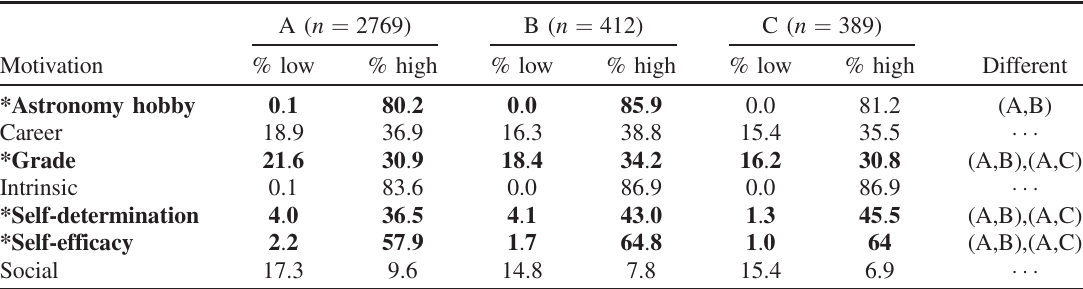
TABLE V. Comparison of percentages of learners in low and high tiers of each motivational category for those who A — dropped out before the first peer graded assignment, B — dropped out after the first peer graded assignment, and C — finished the course. The Kruskal-Wallis test was performed on each line and statistically significantly different groups per Dunn ’ s post hoc test at p ¼ 0 . 05 level are listed in the last column.